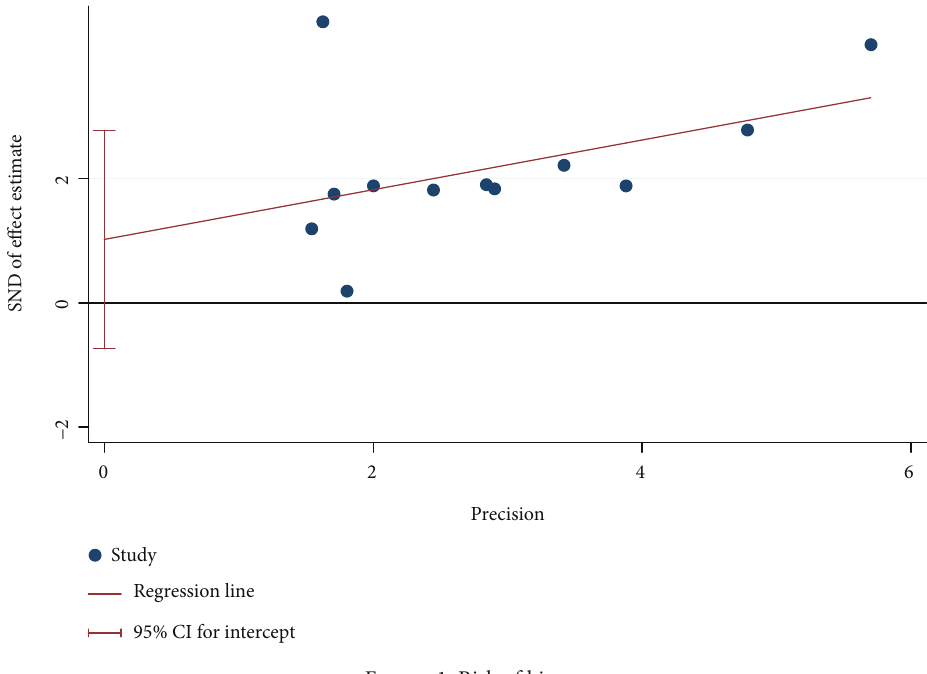
Figure 1: Risk of